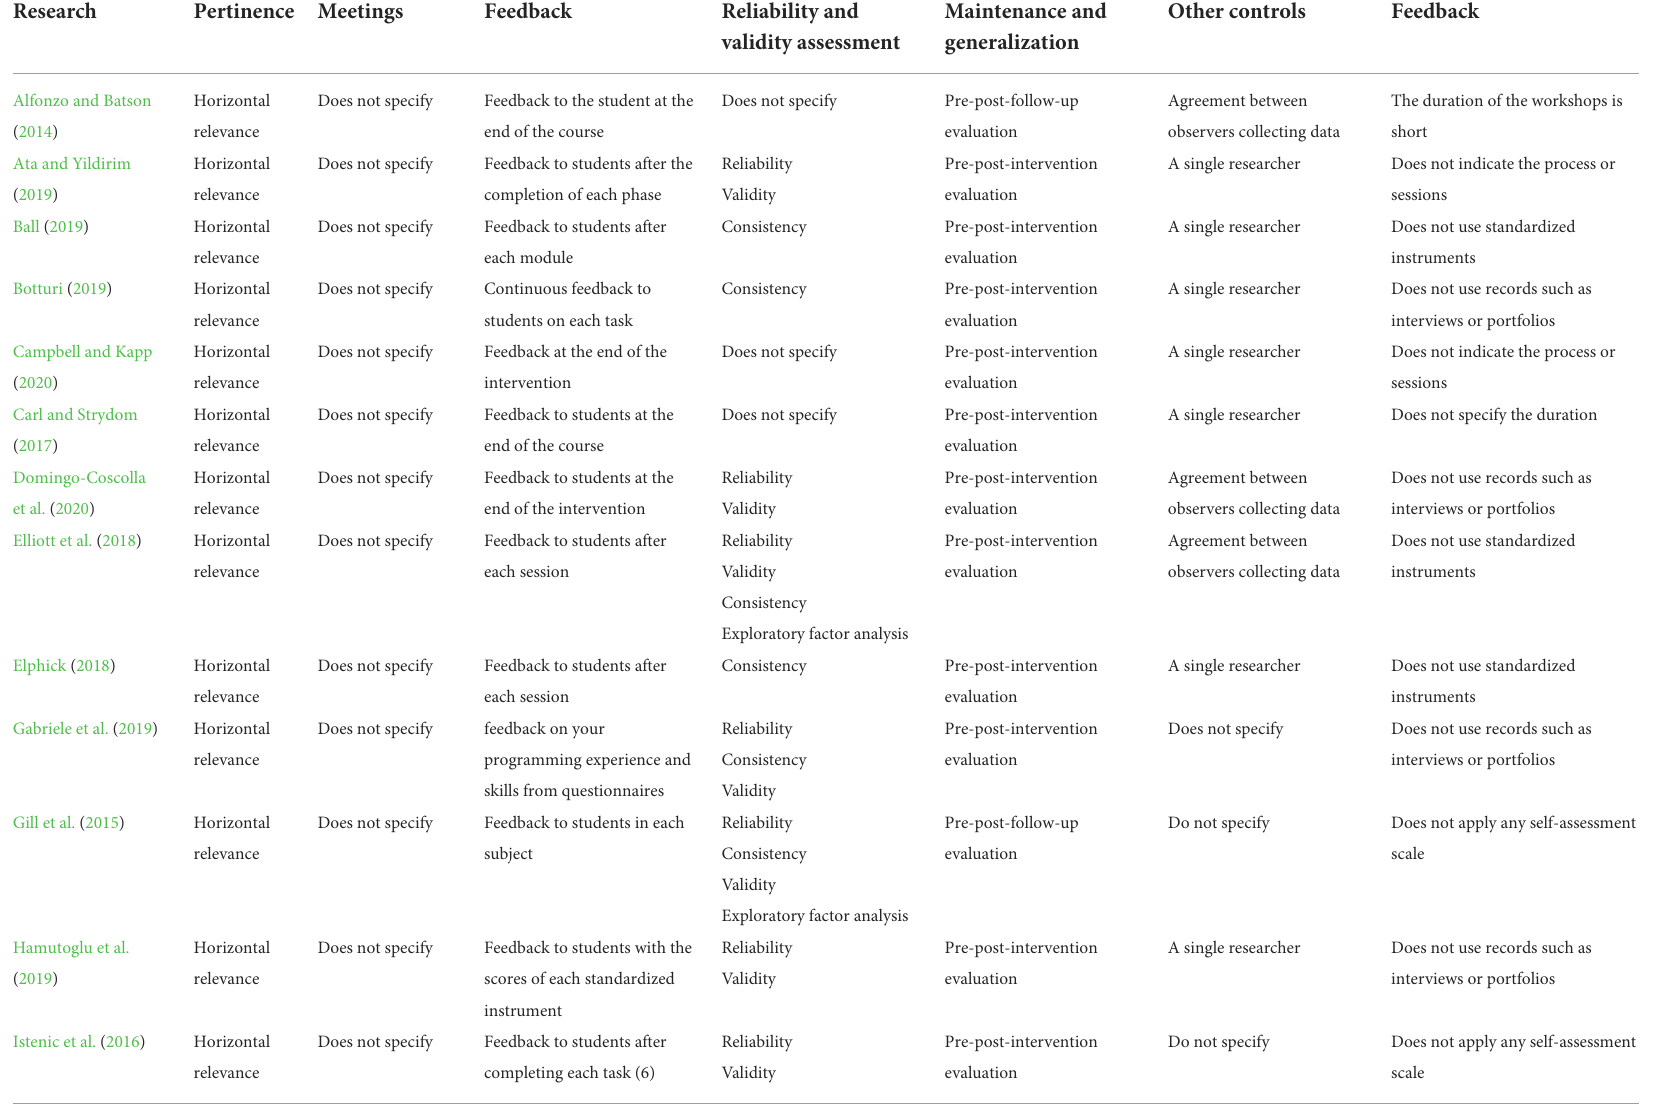
TABLE 5 Treatment